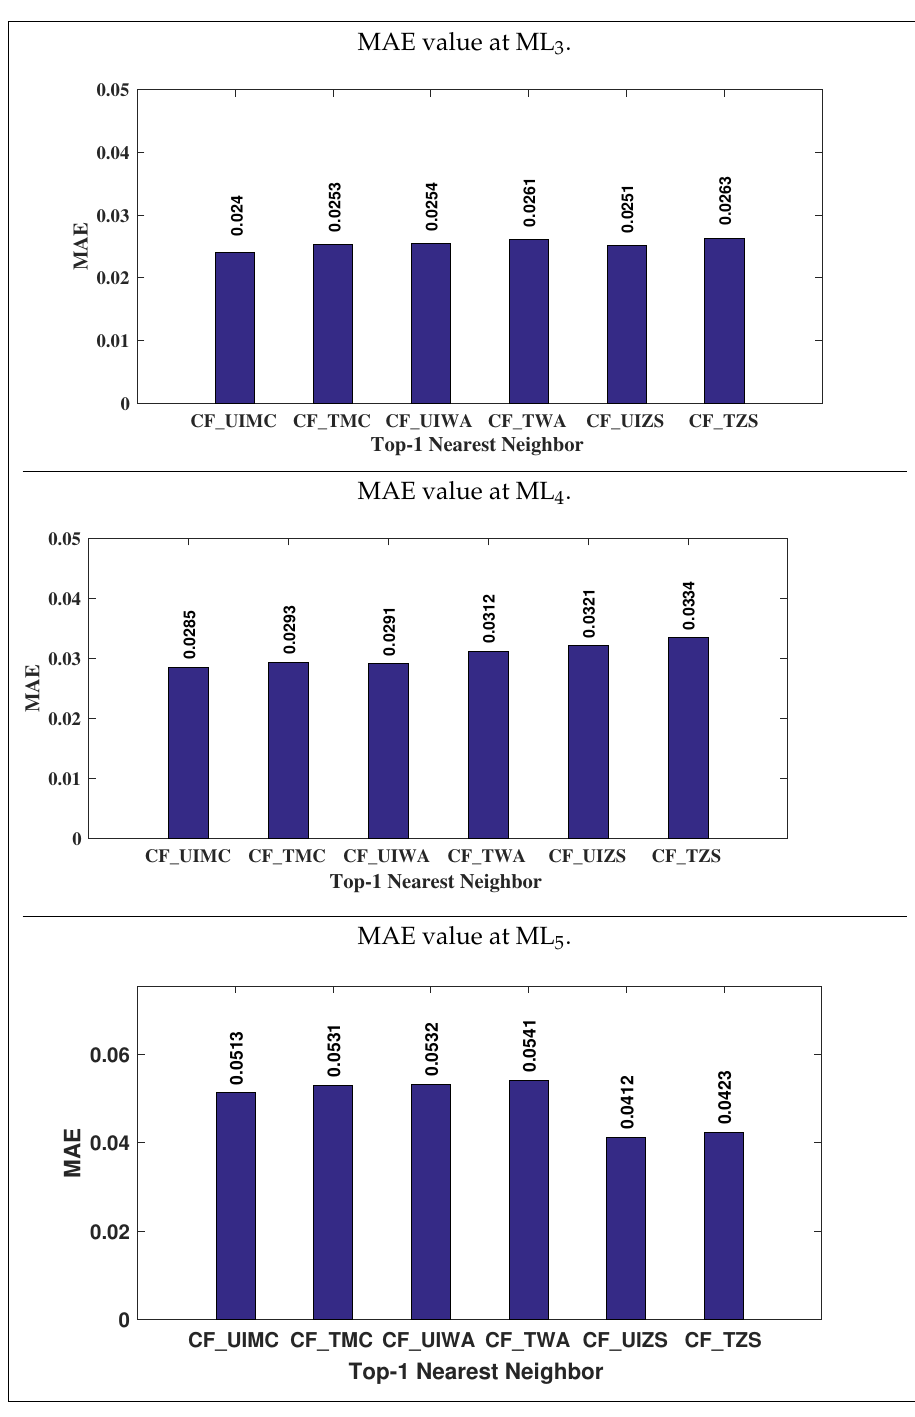
Figure 7. MAE Value at